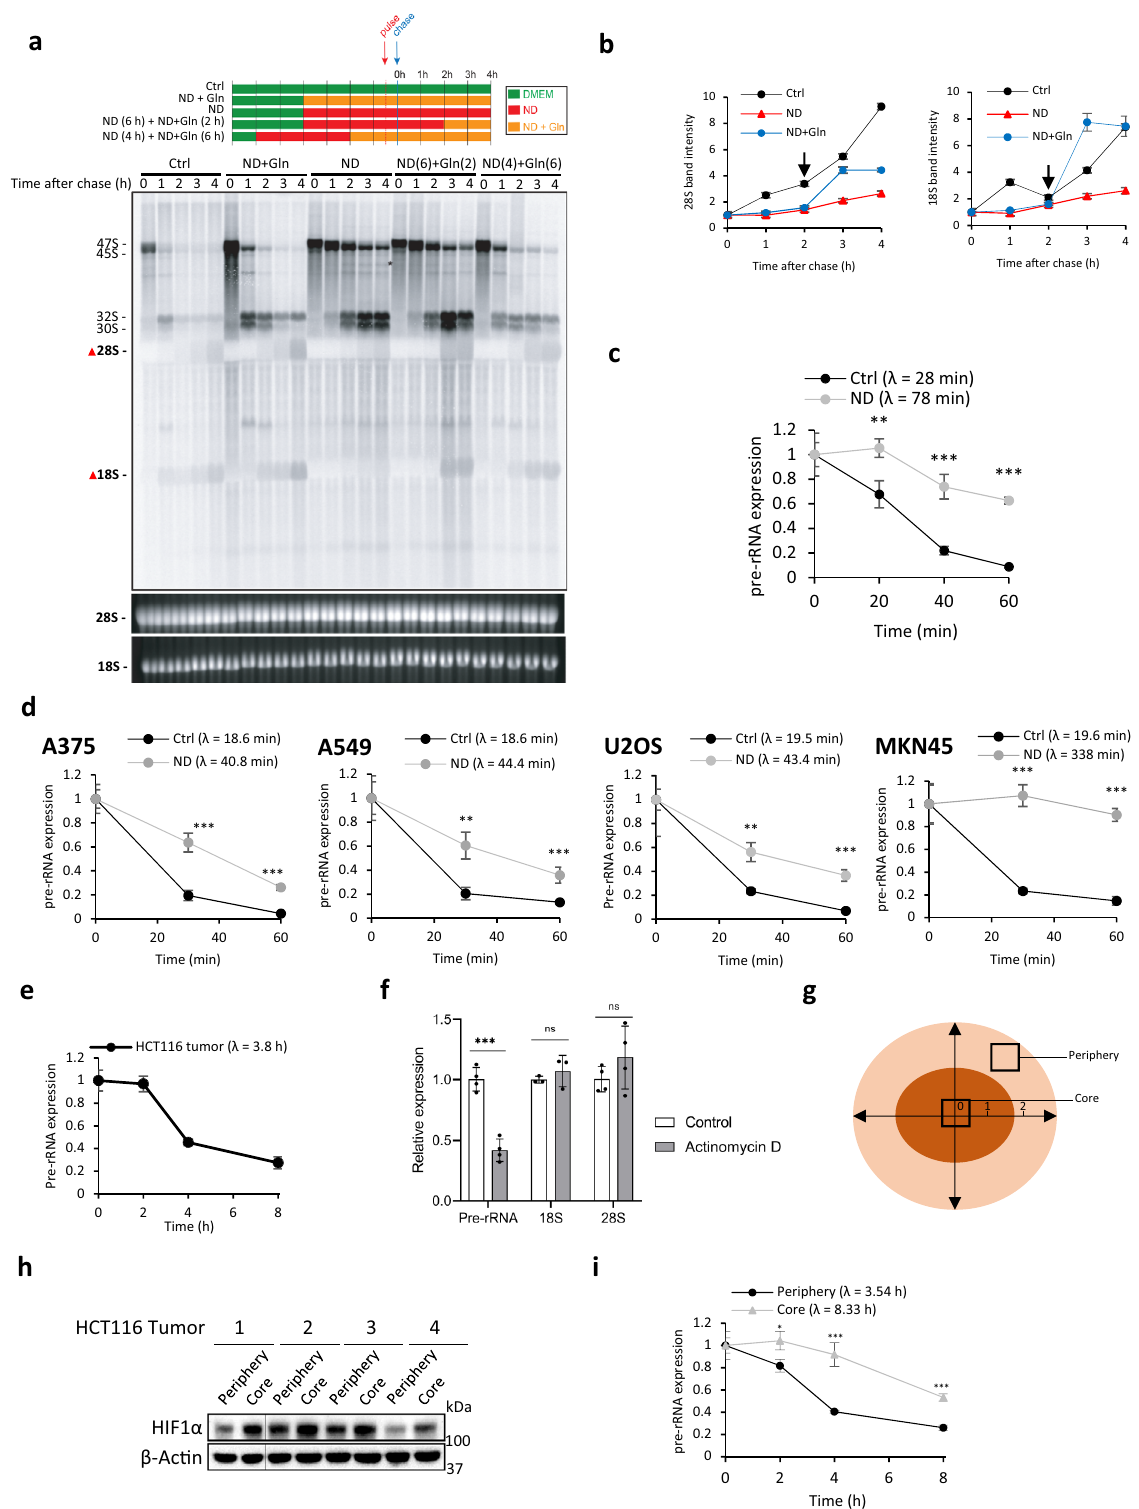
To rigorously con fi rm that ND slows pre-rRNA processing, we measured the pre-rRNA half-life using qRT-PCR and the 5 ′ ETS primers (Supplementary Fig. 1d). Transcription was blocked in control and ND HCT116 cells using actinomycin D (20 μ M),